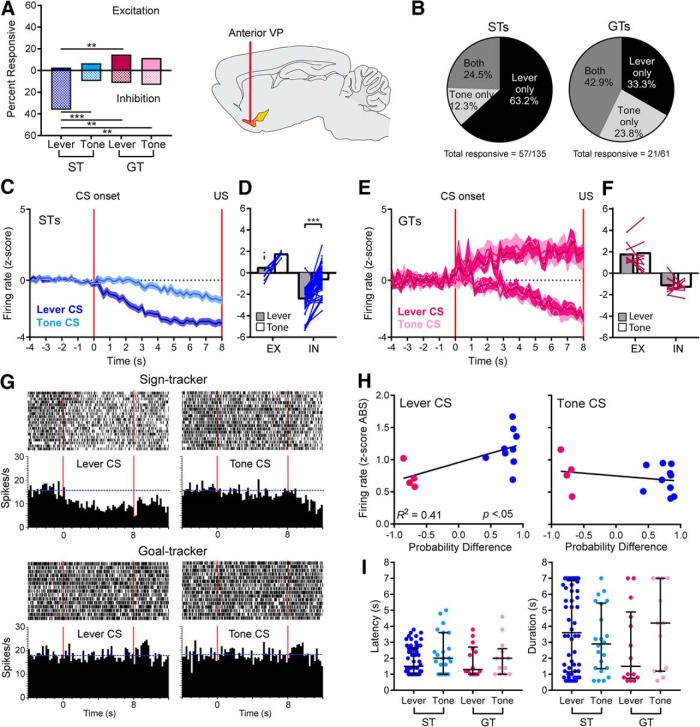
Anterior VP. STs showed sustained changes in neural activity during the cue exposure period of lever-CS trials, but these responses were predominantly inhibitory with few excitations. A, The percentage of cells that showed inhibitory responses during cue exposure was significantly greater in the ST-Lever condition than the ST-Tone, GT-Lever, and GT-Tone conditions, although the percentage of excitatory responses was significantly higher for GT-Lever than ST-Lever (**, p < 0.01; ***, p < 0.001). B, Most ST cells were responsive only to the lever and not the tone; however, GT cells responded to the lever only, tone only, or both at similar rates. C, The average magnitude of change (mean ± SEM) is shown for inhibitions in STs, and is much stronger during lever-CS trials compared to tone-CS trials (excitatory responses were too few to graph). D, STs showed significant within-cell differences in inhibition, with lever-CS trials eliciting lower firing rates than tone-CS trials (***, p < 0.001; gray and white bars represent mean firing rate; EX, excitation; IN, inhibition). E, Among the relatively few GT cells that were responsive to cue exposure, there was no difference in the average magnitude of excitatory or inhibitory change. F, Individual GT cells did not show significant changes in firing magnitude between lever-CS and tone-CS trials. G, Representative cells are shown from a ST (top) and a GT (bottom). Blue horizontal dashed lines represent the baseline firing rate, and red vertical lines mark the beginning and end of the 8-s cue exposure period. The ST cell showed a reduction in firing during lever-CS trials that was not seen in tone-CS trials. The GT cell did not show significant changes in firing during exposure to the lever-CS or the tone-CS, which was typical of most GT cells. H, In lever-CS trials, probability difference scores were significantly correlated with average changes in firing for each rat, though there was no correlation in tone-CS trials. I, The characteristics of neural responses (latency and duration) did not differ significantly between groups (figures show values for individual units, with median and interquartile ranges).